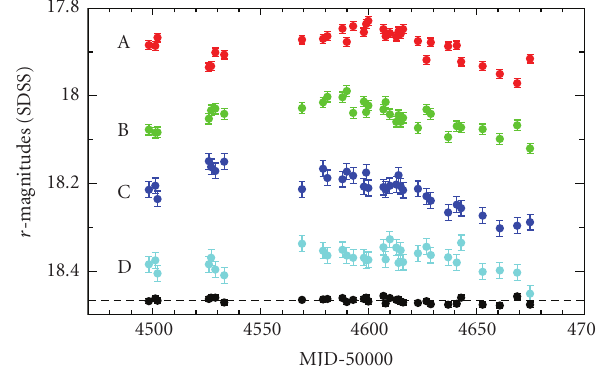
Figure 7: LRT light curves of the four images A–D of H 1413 + 117 (Cloverleaf QSO). These r -band records correspond to the LQLM II observational